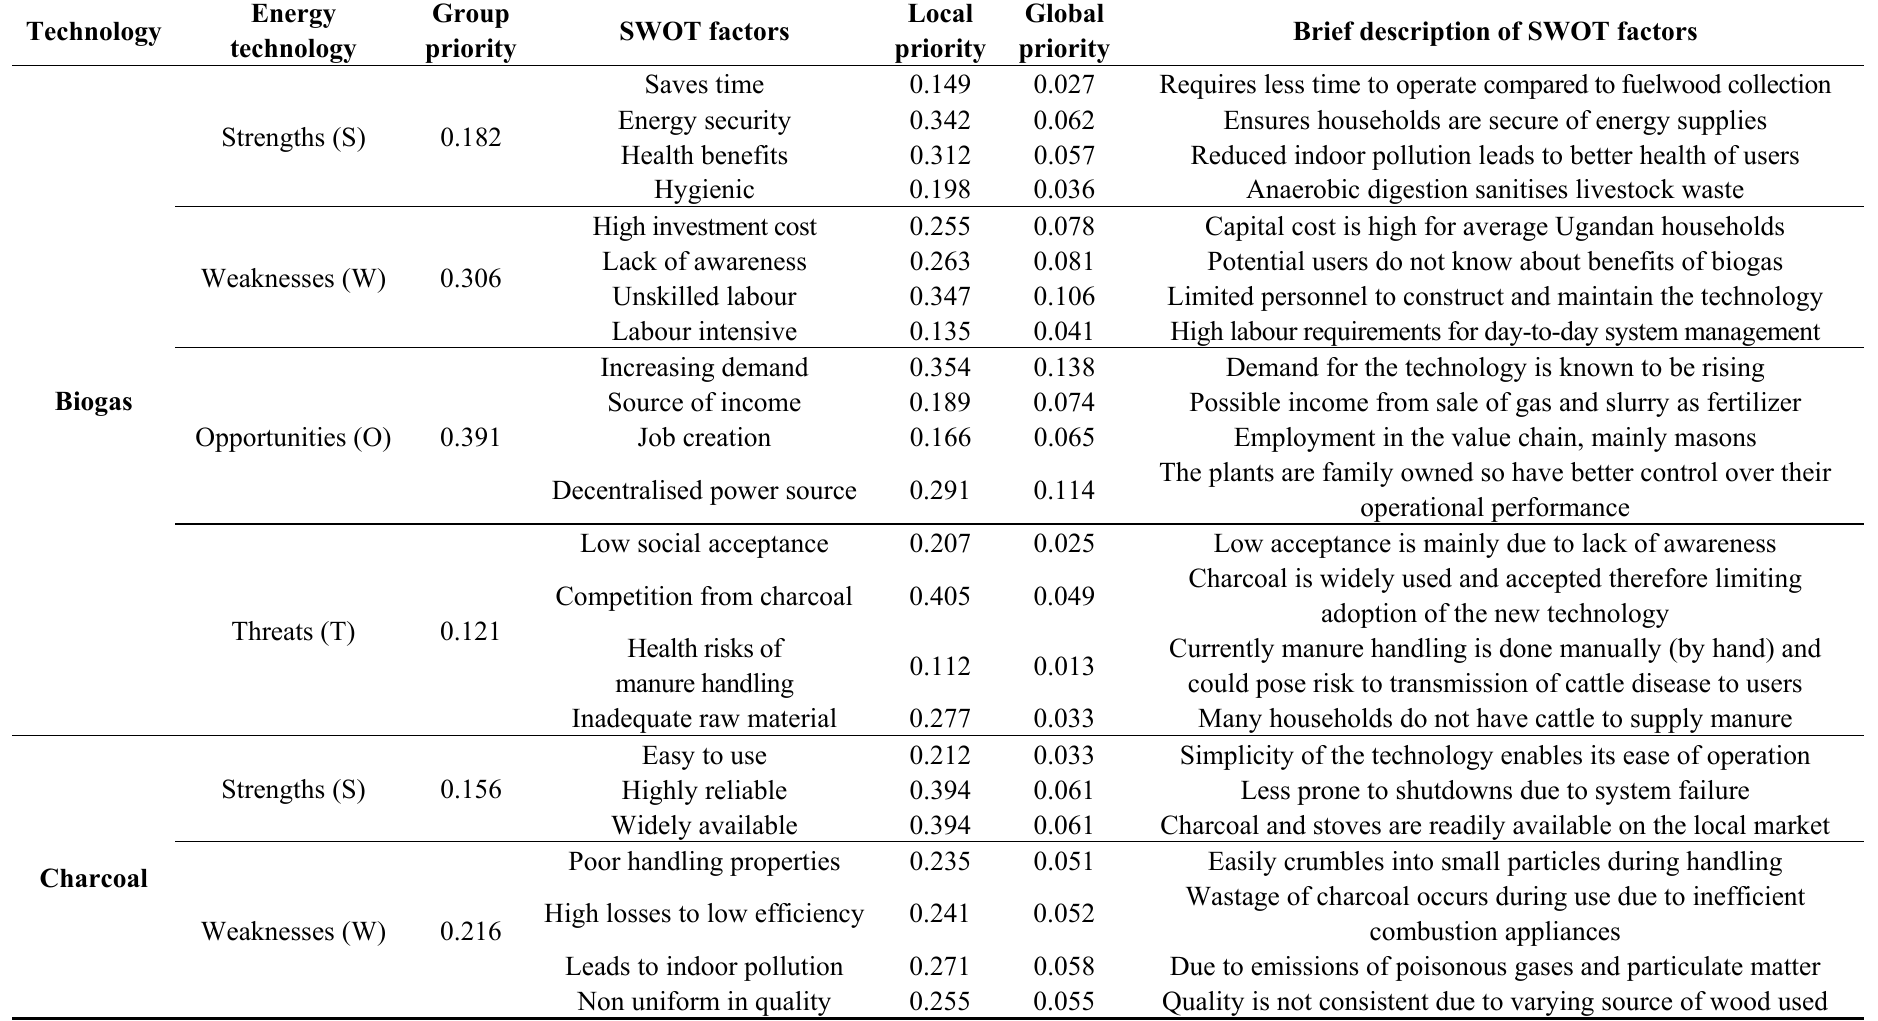
Table A1. SWOT factors and their rankings as identified by